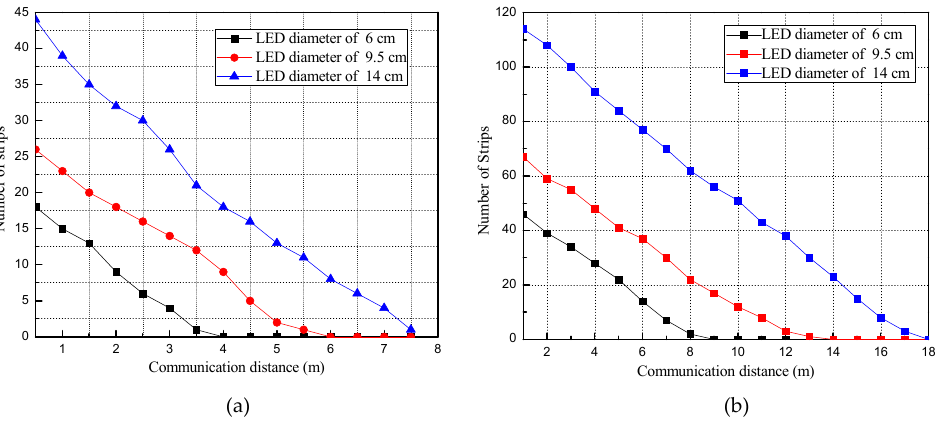
Figure 7. Distance problem visualization for a smartphone-based OCC system. ( a ) LEDs at various distances, ( b ) image of LEDs after changing the exposure duration to 1/8000 s.